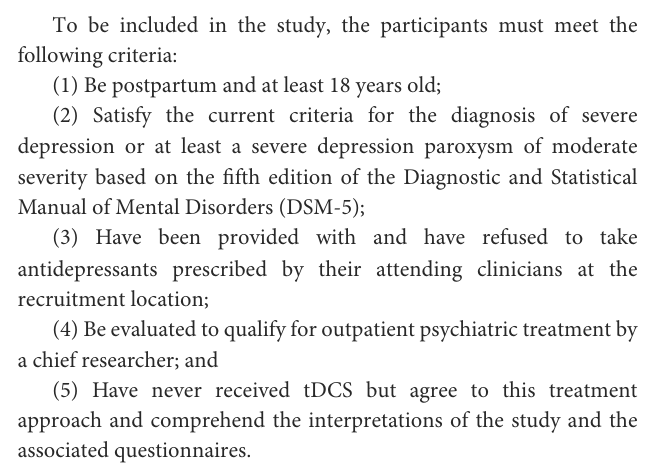
TABLE 1 Data on the design of the study. Point in time